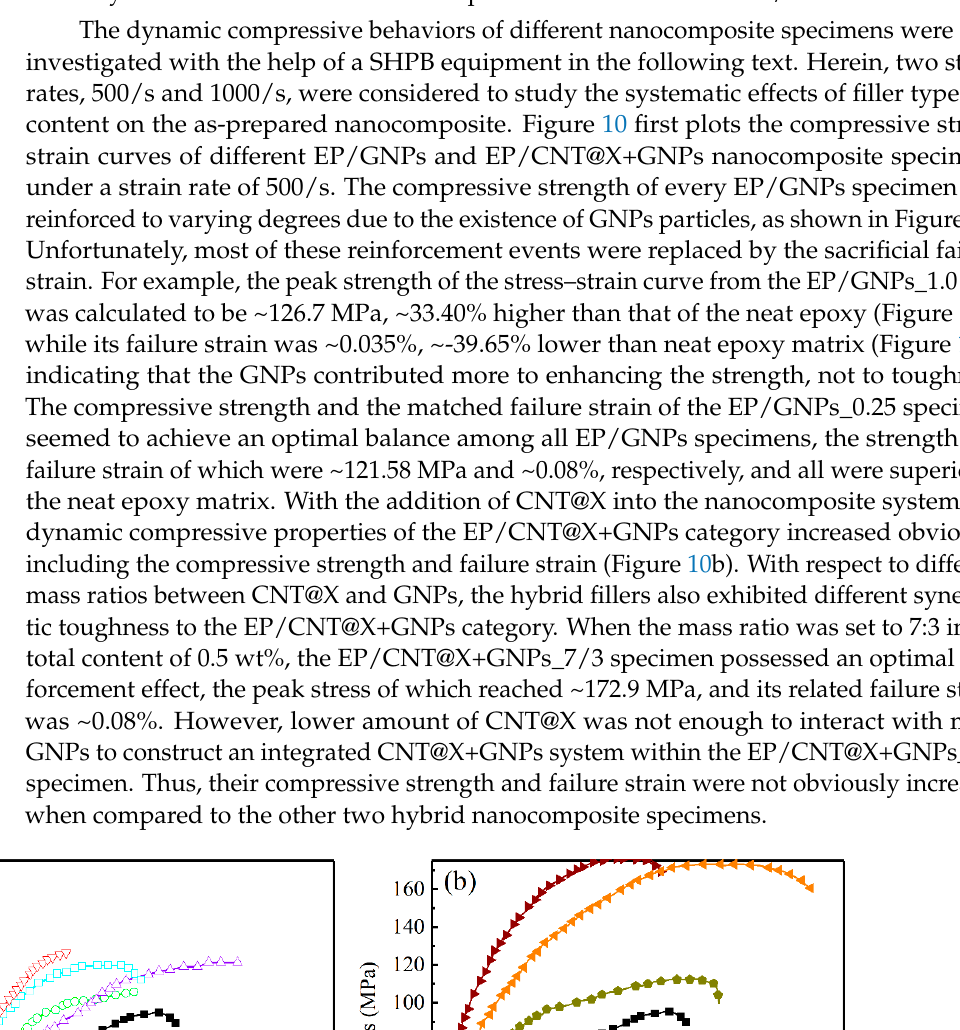
Figure 9. Schematic diagram showing the interaction of the crack front with GNPs and CNT@X+GNPs particles.